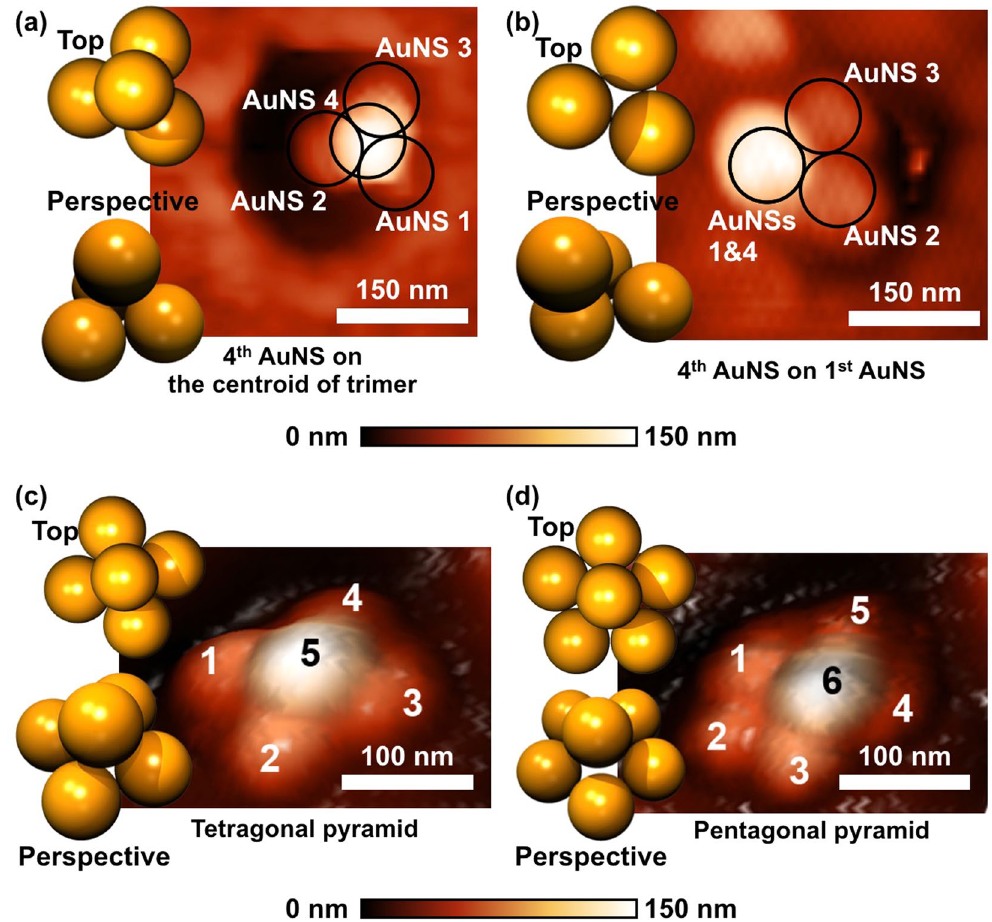
Figure 3. Representative examples of the 3D plasmonic metamolecules assembled via template AFM nanomanipulation. All these 3D plasmonic metamolecules are composed of 77 nm AuNSs. ( a ) 2D AFM image of the symmetric tetrahedral cluster. ( b ) 2D AFM image of asymmetric tetrahedral cluster (fourth AuNS located on the center of the first AuNS). ( c ) 3D AFM image of the 3D cluster with the tetragonal pyramid (i.e., 5 th AuNS onto the centroid of the bottom tetramer). ( d ) 3D AFM image of the 3D cluster with the pentagonal pyramid (i.e., 6 th AuNS onto the centroid of